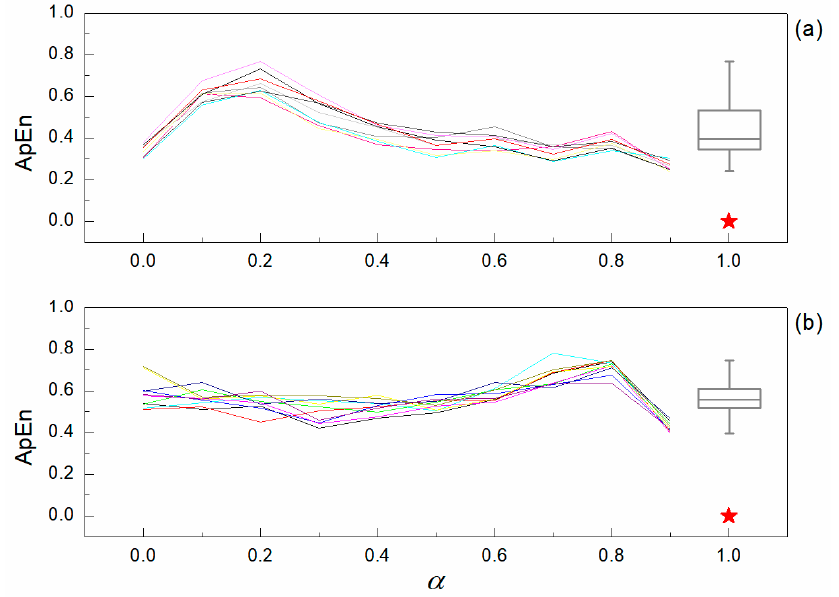
Figure 5. The ApEn values of two mixed ideal series with different mixing ratios. ( a ) Time series y 1 mixed by x 1 and x 2 ; ( b ) time series y 2 mixed by x 1 and x 3 .